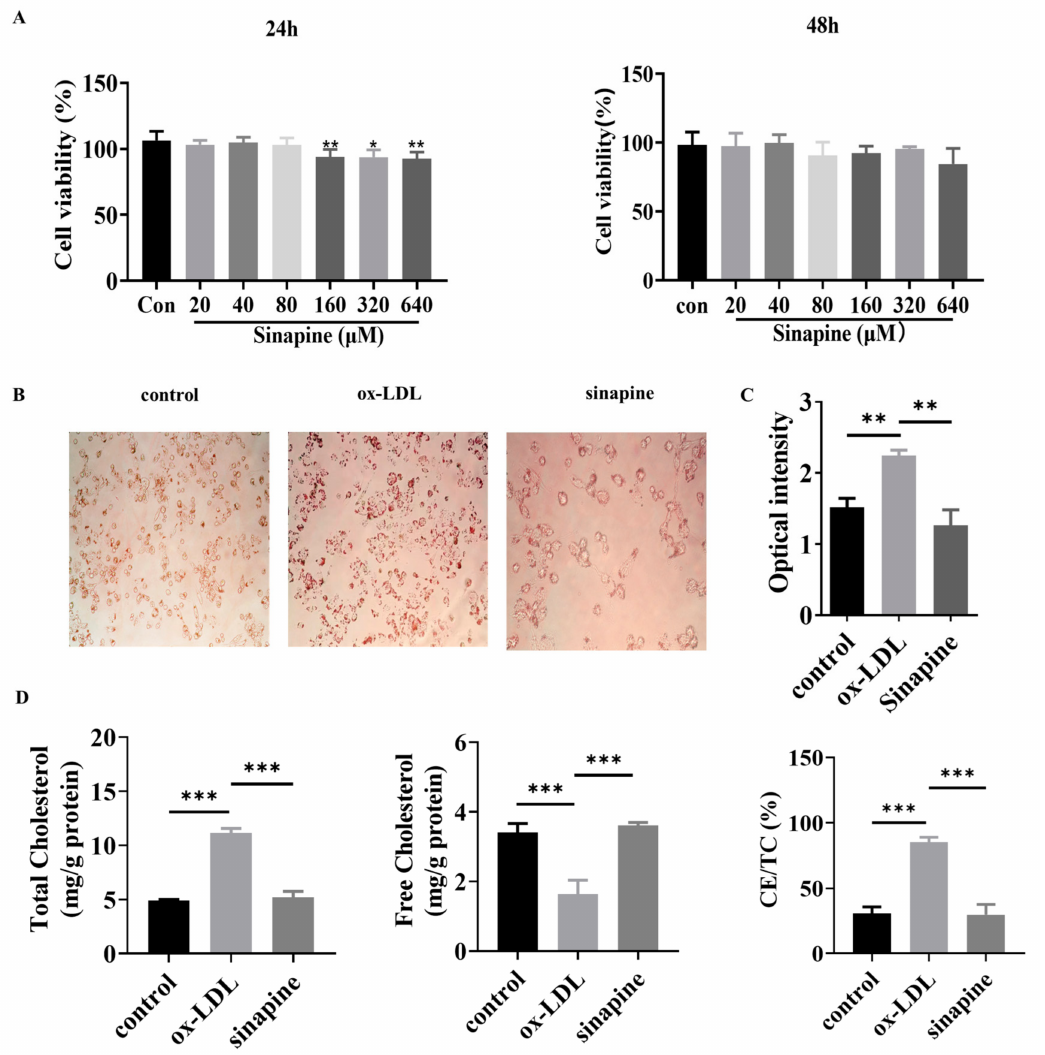
Figure 2. Effects of sinapine on foam cells. ( A ) Effect of sinapine concentration (0–640 µ M) on cell viability. ( B , C ) Oil Red O staining results and semi-quantitative analysis. ( D ) Effect of sinapine (80 µ M) on total cholesterol (TC), free cholesterol (FC), and ratio of cholesterol ester to total cholesterol (CE/TC) in macrophages. Note: * p < 0.05, ** p < 0.01, and *** p <